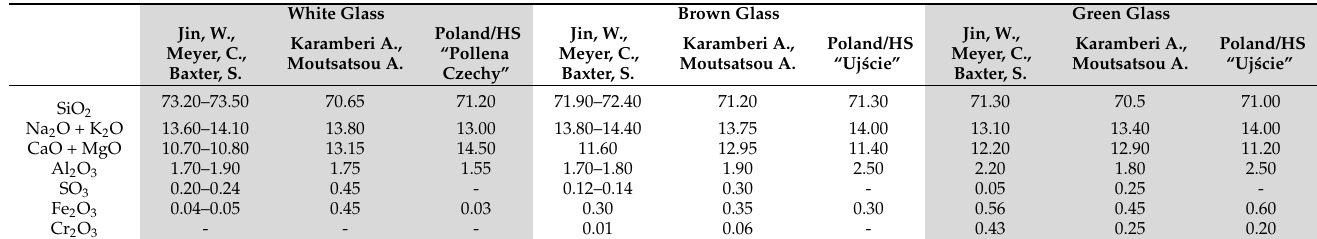
Table 1. Chemical compositions of glass by colours (content in % by weight)